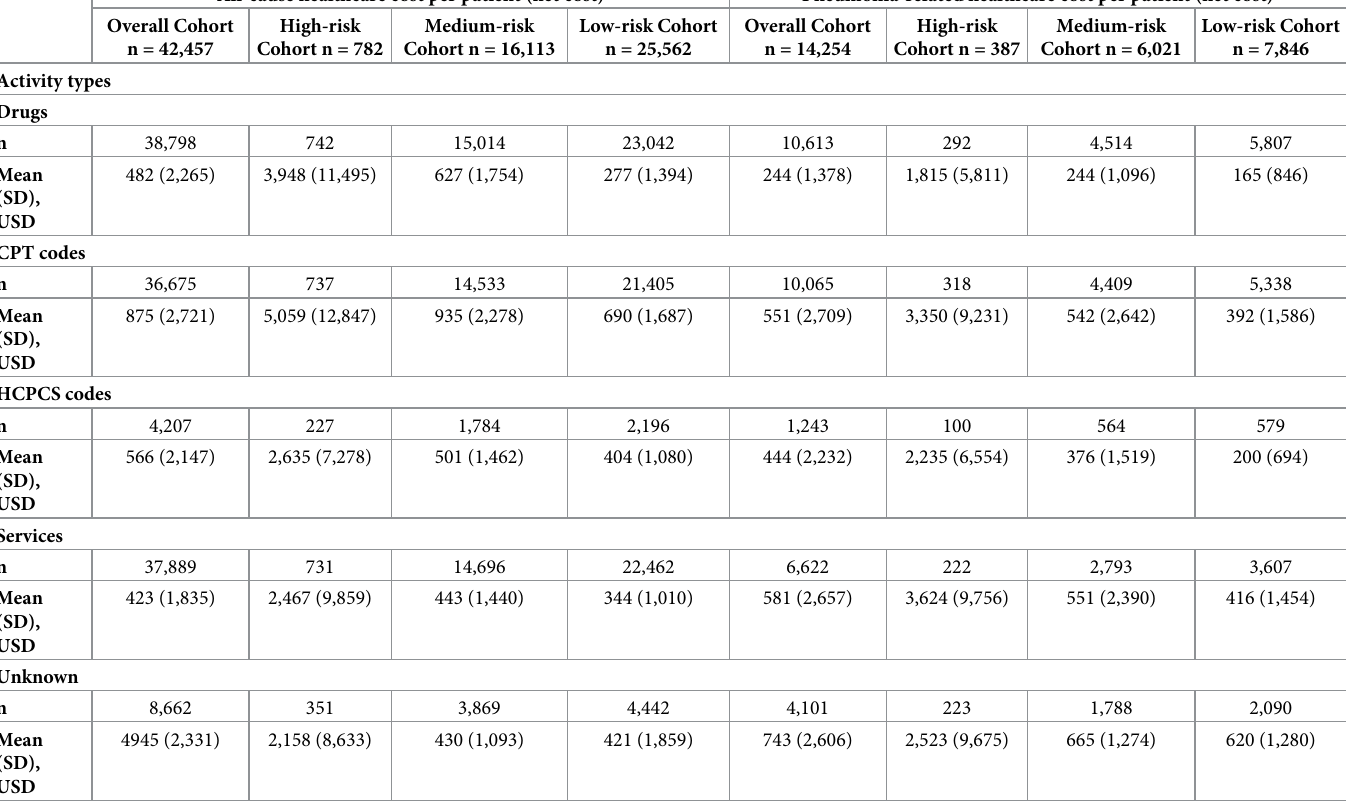
Table 5. Healthcare cost per patient based on activity type (all-cause and pneumonia-related) during 12-month follow-up (patients having at least one claim for pneumonia during 12-month follow-up period were included in the analysis; Dubai Real-World Claims Database, 2014 to 2019). All-cause healthcare cost per patient (net